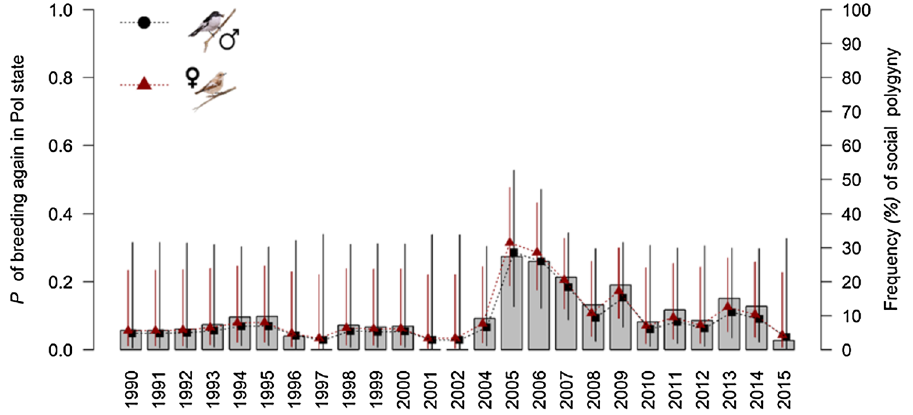
Figure 3. 95%CI estimates of the probability of breeding two consecutive years in a polygamous state according to the frequency of social polygyny (grey bars) in the previous year for males and females